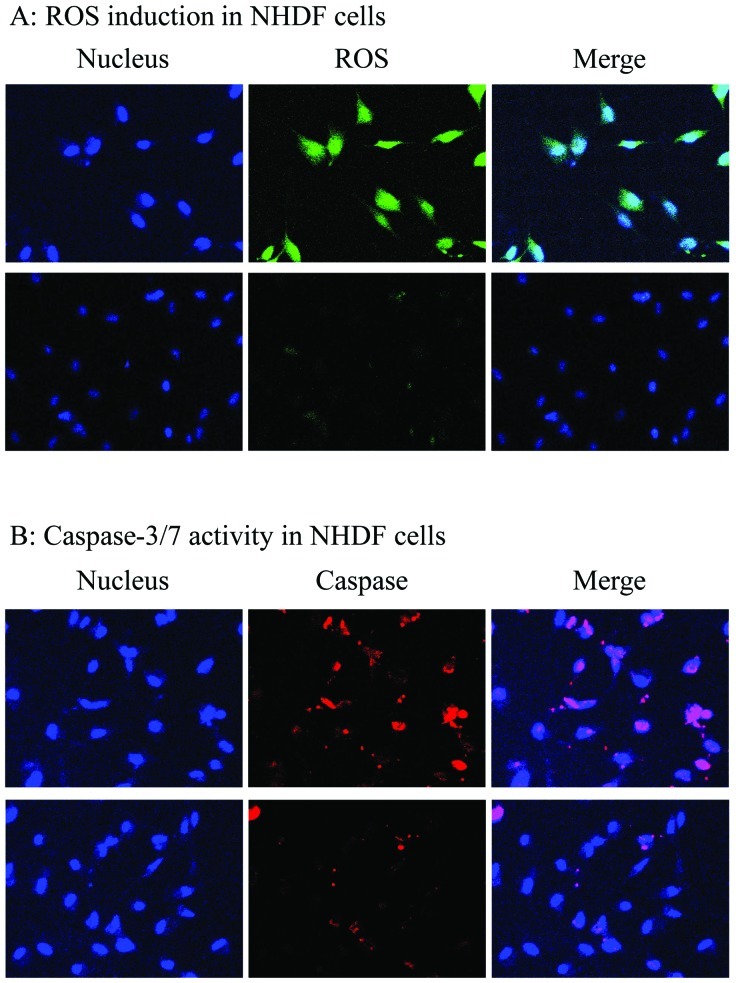
(A) Cells inducing reactive oxygen species (ROS) in siControl-treated (top panel) and siPSD-treated NHDF cells (bottom panel). Nuclear morphology of cells stained with Hoechst 33342 (blue, left), cells inducing ROS stained with Total ROS/Superoxide Detection kit Reagent (green, middle), and merged staining with both reagents (white green, bottom). (B) Cells expressing active caspase-3/7 in siControl-treated (top panel) and siPSD-treated NHDF cells (bottom panel). Nuclear morphology of cells stained with Hoechst 33342 (blue, left), cells expressing active caspase-3/7 stained with CaspaTag Reagent (red, middle), and merged staining with both reagents (pink, right).